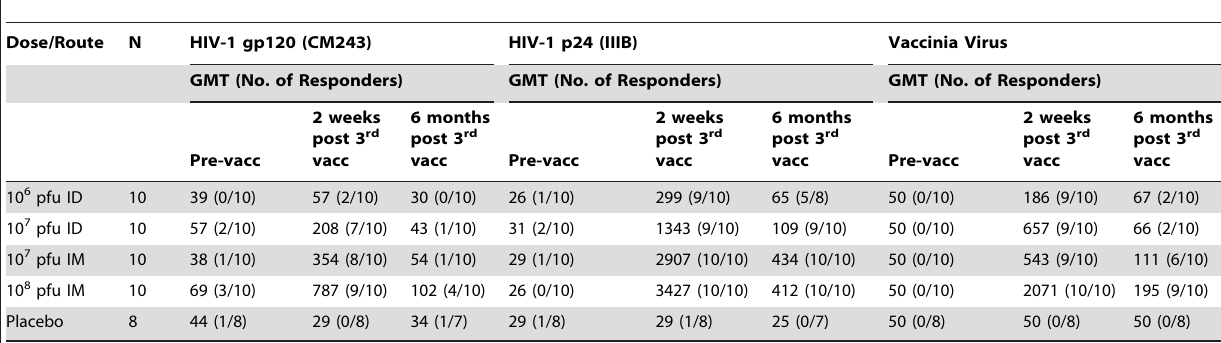
Table 6. Geometric Mean Antibody Titers and Response Frequency to HIV Proteins and Vaccinia*.